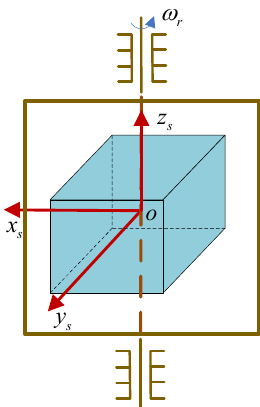
Figure 1. Installation diagram of the single-axis